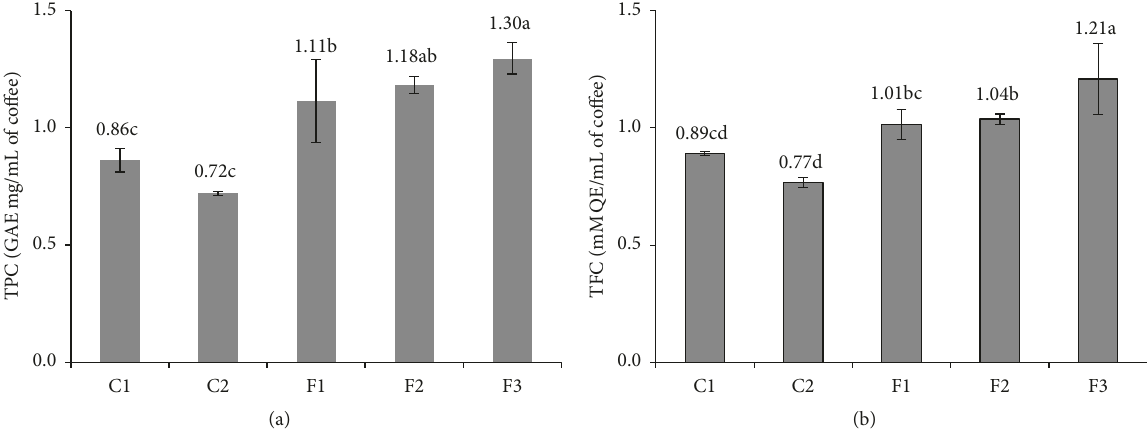
Figure 2: Total polyphenol (a) and flavonoid (b) contents of yeast fermented coffee extracts. Different letters meant significant difference at P < 0.05 by Fisher’s least significant difference